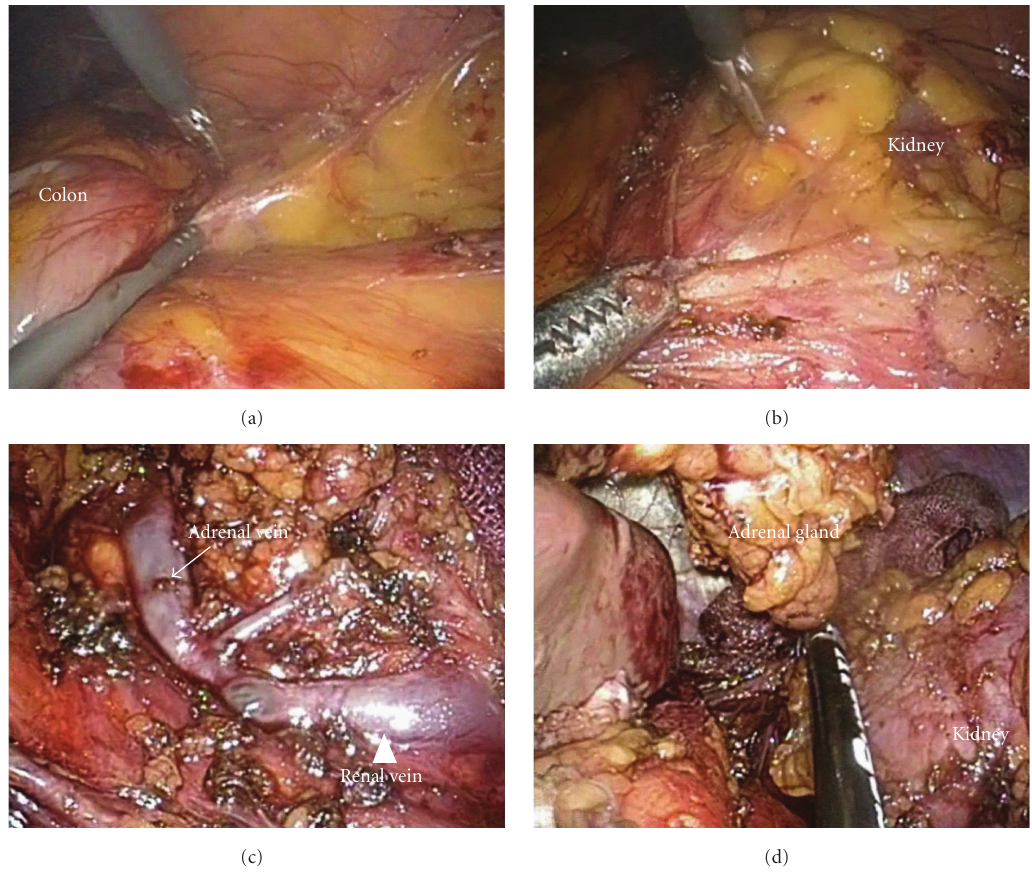
Figure 3: Intraoperative findings. (a) Incision of the white line of Toldt, (b) dissection of the junction of the colonic mesentery and Gerota’s fascia, (c) renal vein (arrowhead) and left adrenal vein (arrow), and (d) adrenal dissection with a vessel-sealing